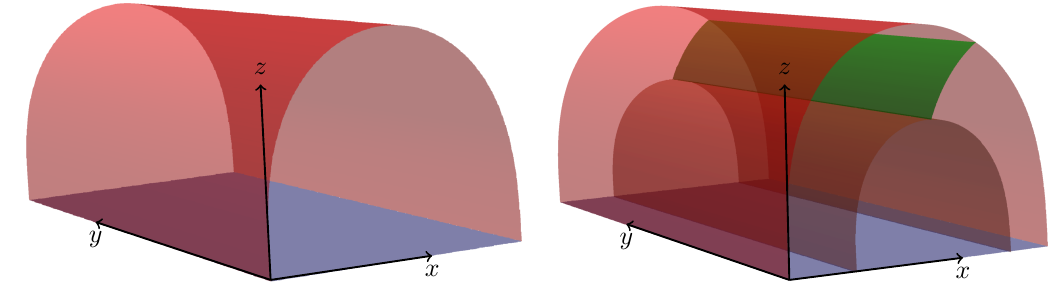
Figure 2 . The left plot: the minimum surface for a given width w . The right plot: the minimum cross-section (green surface) of the entanglement